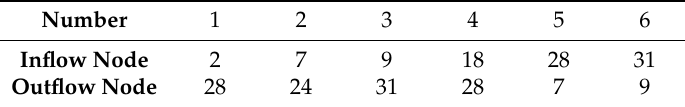
Table 4. The pair of exciting current nodes.